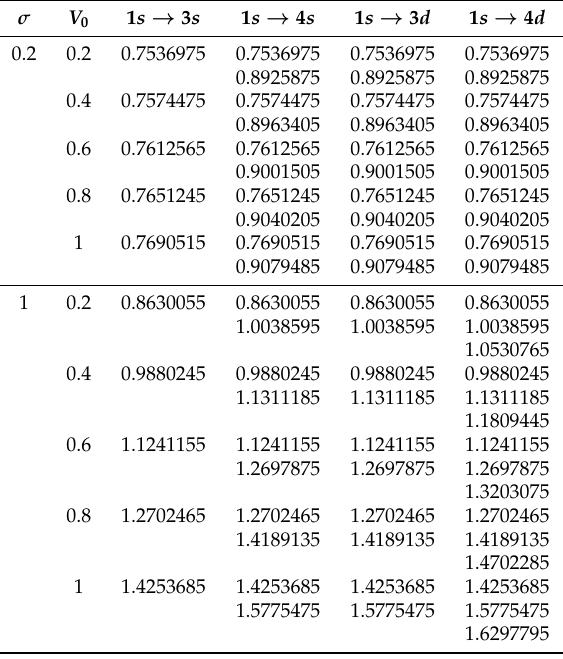
Table 3. Two-photon resonance enhancement frequencies for various potential widths and depths. The data is in atomic units.